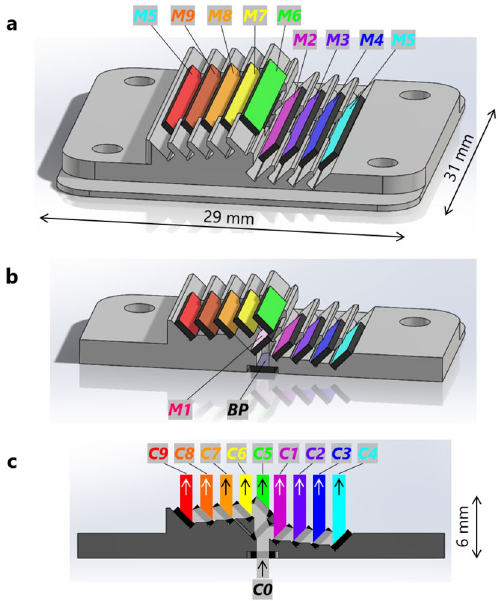
Figure 2. Design of two-layer biparted ten-dichroic-mirror array. ( a ) Perspective and ( b ) cross-sectional views of the two-layer biparted ten-dichroic-mirror array (with size of 29 mm × 31 mm × 6 mm). It consists of five dichroic mirrors ( M1 − M5 ) arrayed on the lower layer, five dichroic mirrors ( M6 − M9 and another M5 ) arrayed on the upper layer, and a bandpass filter ( BP ) below M1 . ( c ) Cross-sectional view from the perpendicular direction, with C0 and C1 − C9